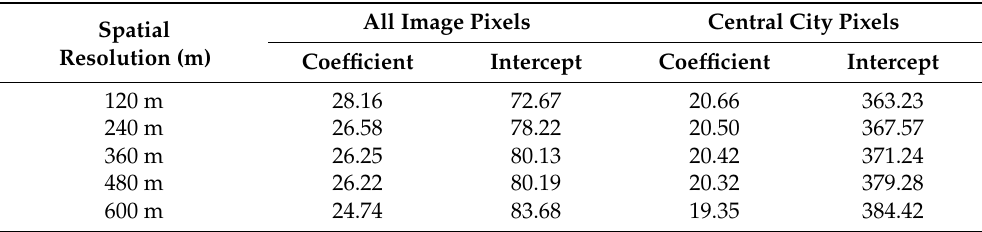
Table 5. Difference between the regression relationships of NTL and POI data at various resolu- tion